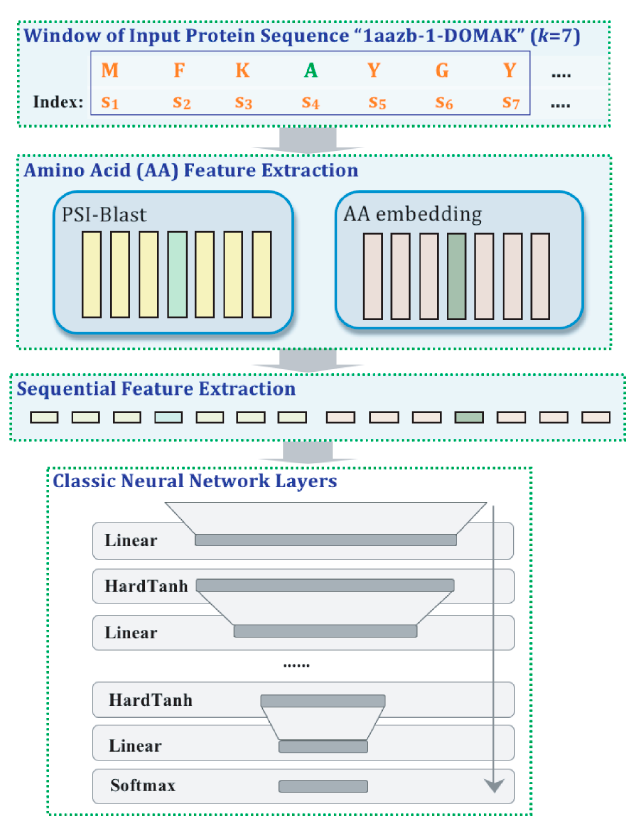
Figure 2. Deep neural network architecture from Yanjun Qi et al. [45]. The input to the first layer is the protein sequence represented by the single-letter amino acid code, for example the letter “A” (in green) represents “Alanine”. This method uses a sliding window input {S 1 , S 2 … S k }, in this case k = 7. The first layer consists a PSI-Blast feature module and an amino acid embedding module, the green boxes represent the feature vector derived from the Alanine in both modules. In the second layer, the feature vectors are concatenated to facilitate identification of local sequence structure. Finally the derived vector is fed into the Deep Artificial Neural Network.